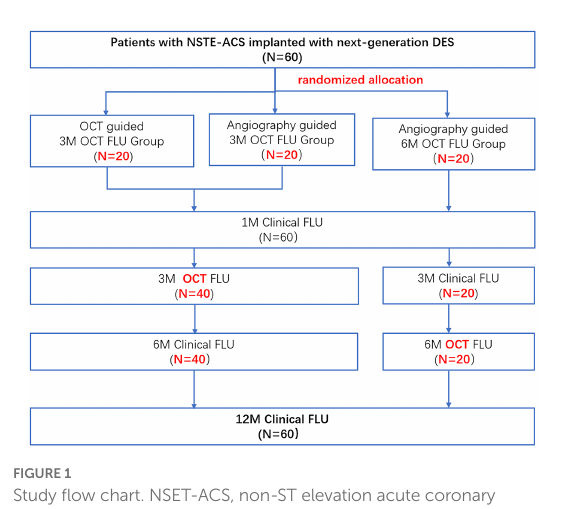
FIGURE 1 Study flow chart. NSET-ACS, non-ST elevation acute coronary syndrome; OCT, optical coherence tomography; FLU, follow up; 3 M, 3-month; 6 M, 6-month; and 12 M,